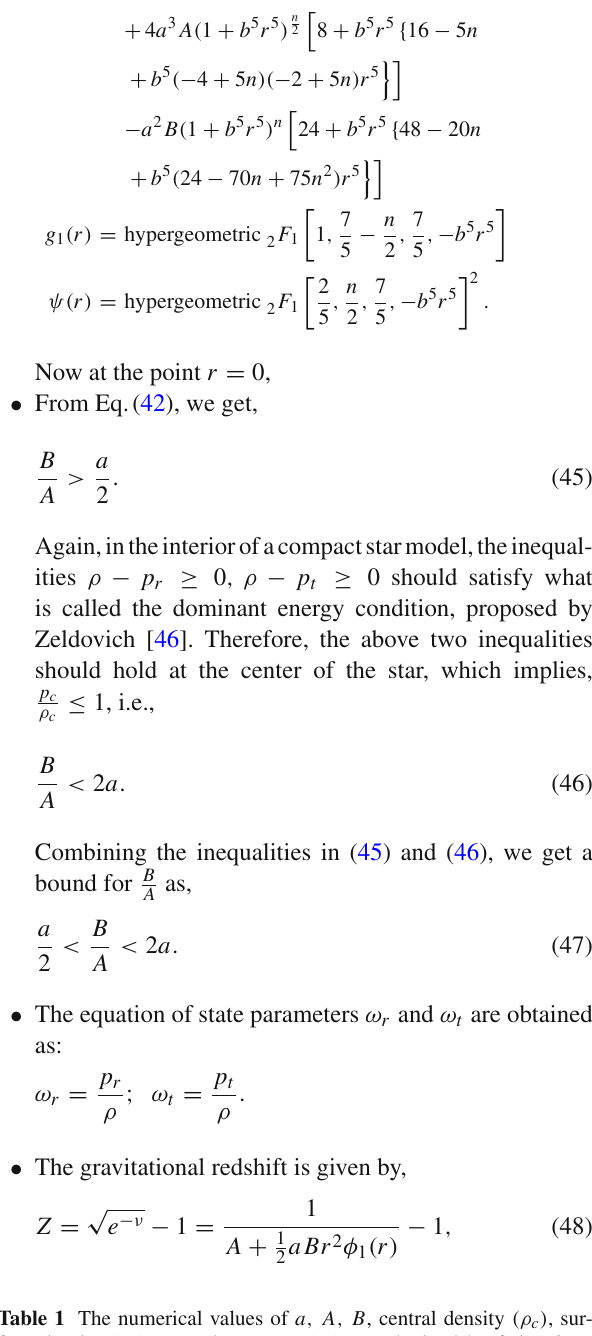
km for different values of n . The units of a , A , B , b , ρ c , ρ s , p